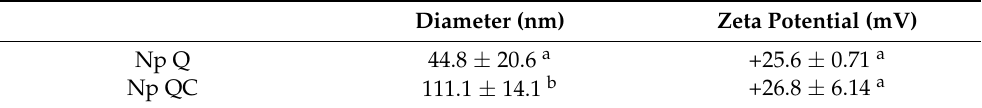
Table 2. Diameter and zeta potential of chitosan nanoparticles (Np Q) and chitosan–capsaicin nanoparticles (Np